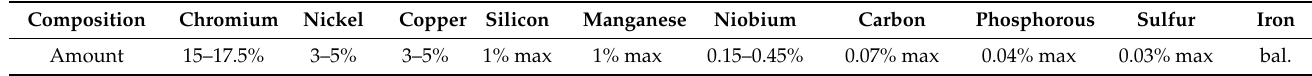
Table 2. Markforged 17-4 PH stainless steel composition [29].